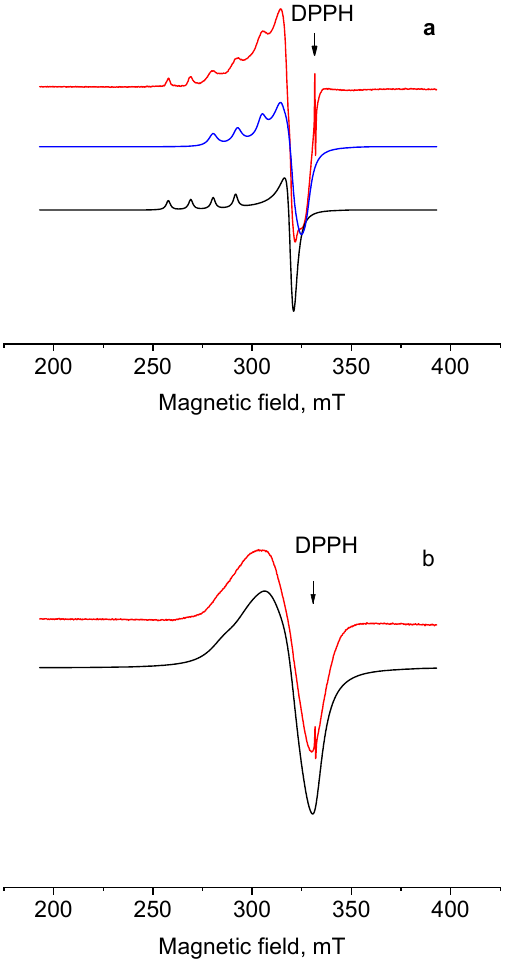
Figure 3. EPR spectra of the reaction solutions before isolation of 3 ( a ) and 4 ( b ) at 77 K. Red—experimental spectra, blue and black—simulated spectra.